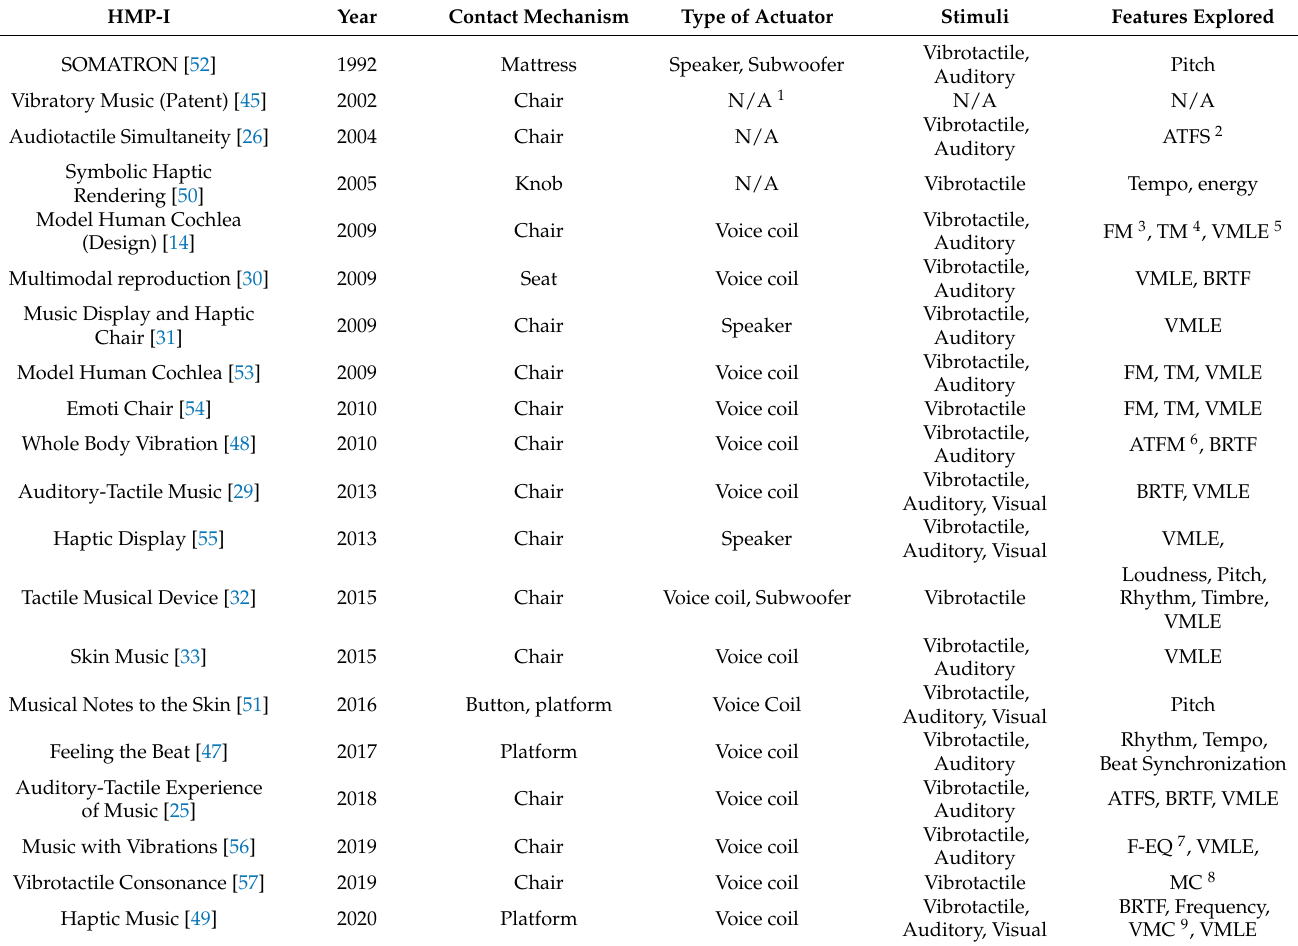
Table 2. Overview of research on haptic music player installations